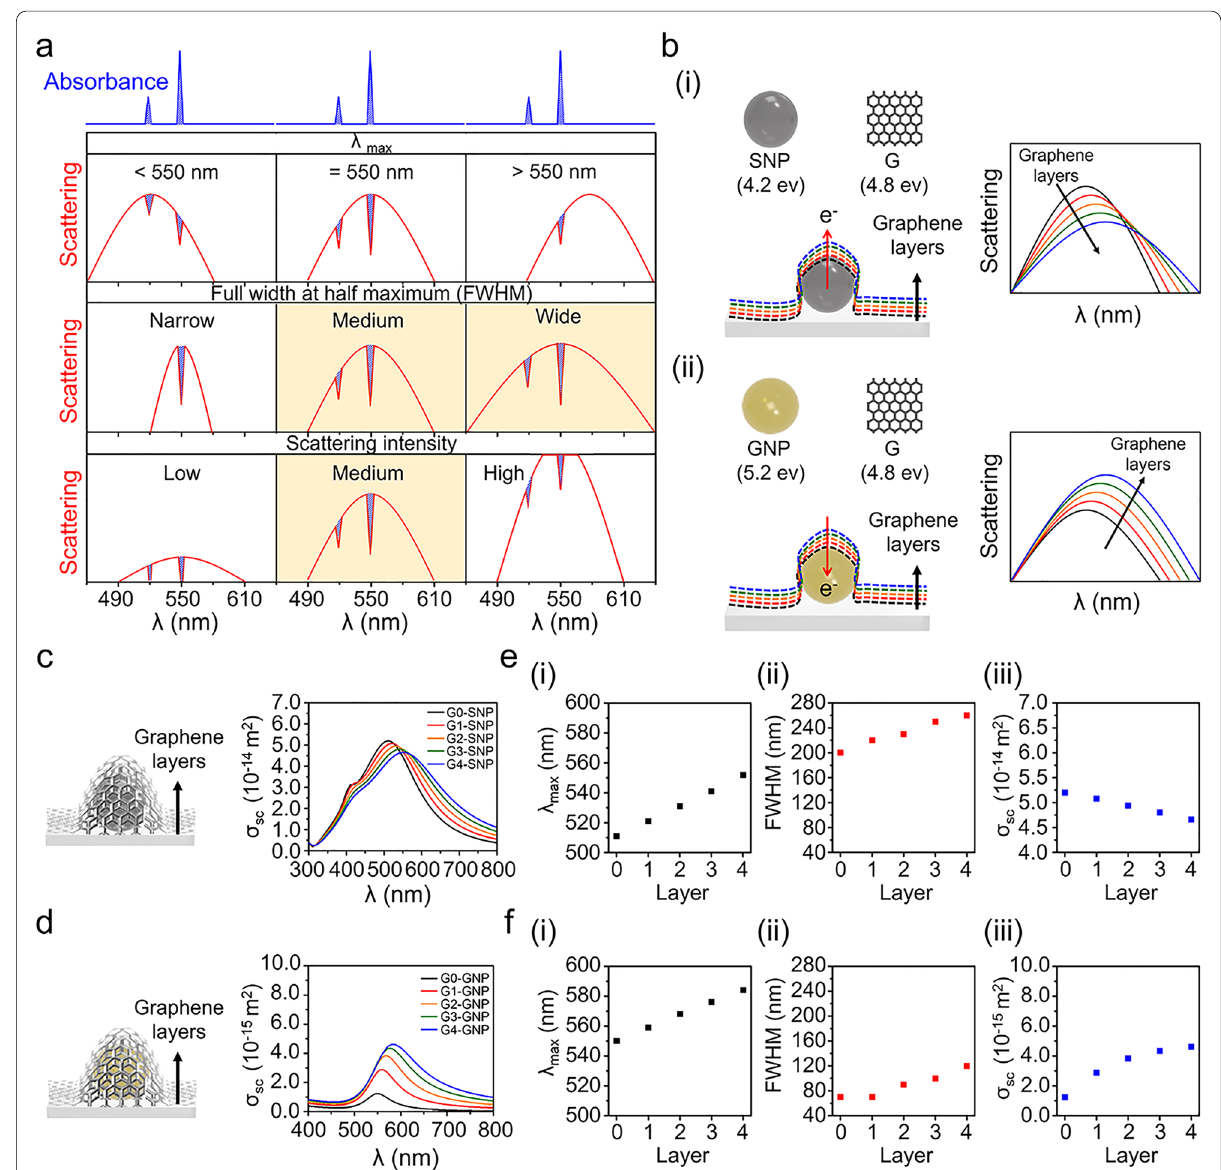
Fig. 2 Cyt c -mediated PRET signals according to scattering profiles of nanoprobes and optical tuning strategy of the nanoprobes with graphene layers. a Expected features of the Cyt c -mediated PRET signal according to scattering profiles of nanoprobes in terms of λ max , FWHM, and intensity. The cases where two unique quenching dips for Cyt c were clearly observed are highlighted with yellow boxes. b The schematic diagram for the relationship of the electron movement through the NP-graphene interface with the change in scattering property according to the covered